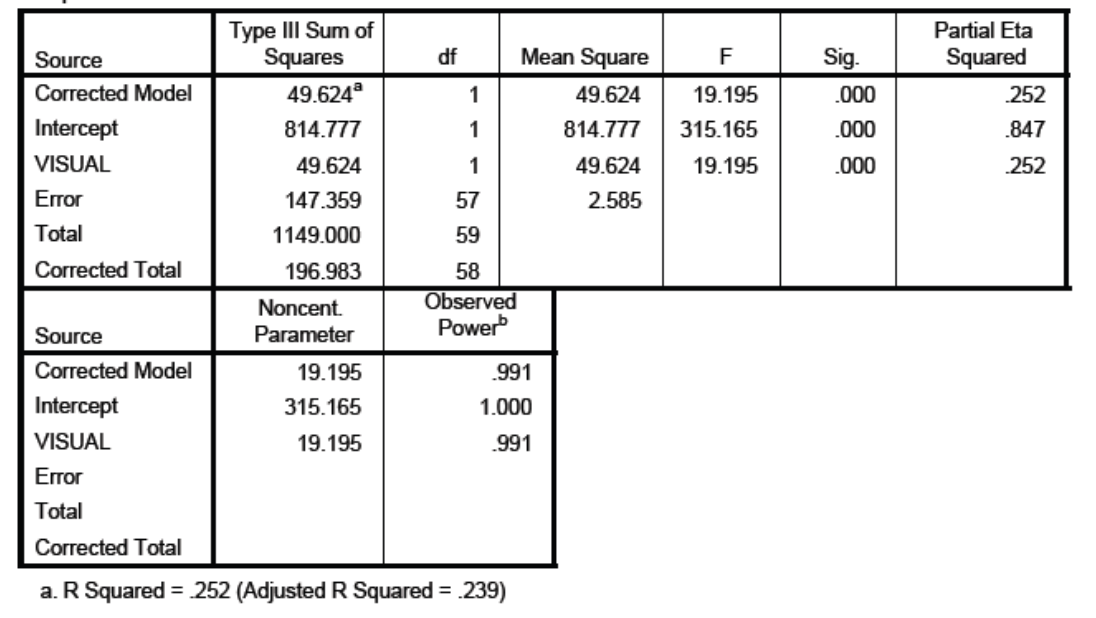
Figure B.21. ANOVA analysing enjoyment levels in regard to visual preference using raw